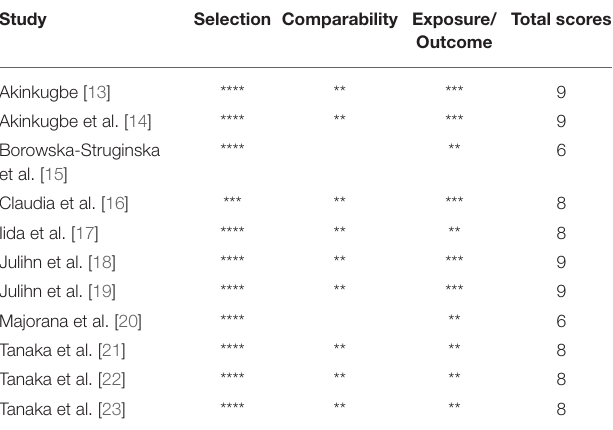
TABLE 2 | The methodological quality of the included studies.